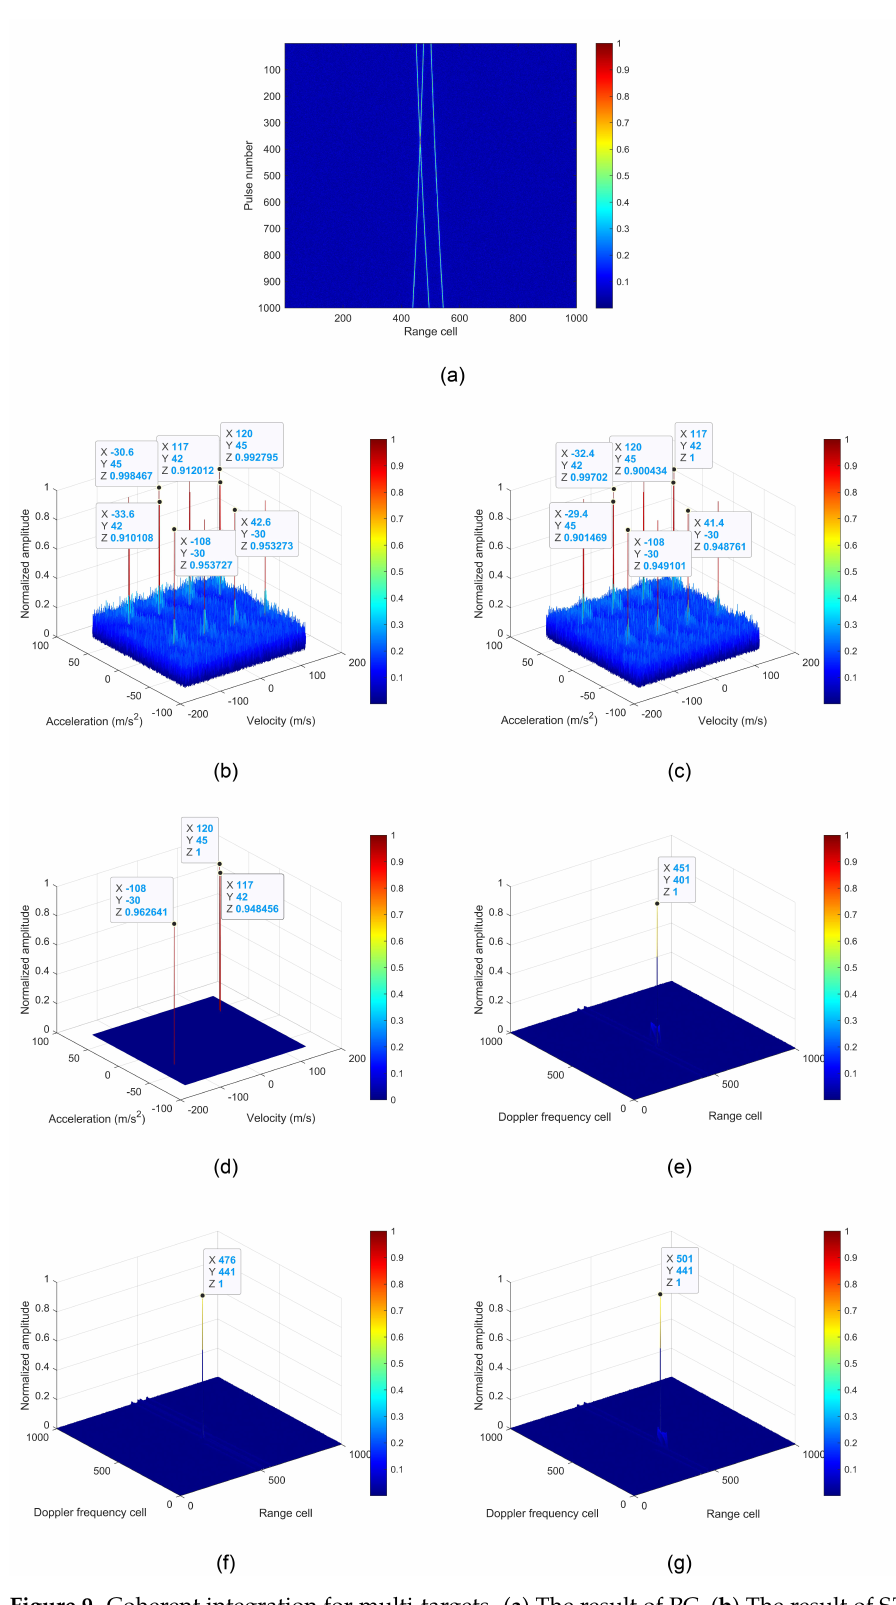
Figure 9. Coherent integration for multi-targets. ( a ) The result of PC. ( b ) The result of SZDCFT at f = − 4 MHz. ( c ) The result of SZDCFT at f = 4 MHz. ( d ) The result of PSZDCFT. ( e ) The result of coherent integration for target A. ( f ) The result of coherent integration for target B. ( g ) The result of coherent integration for target